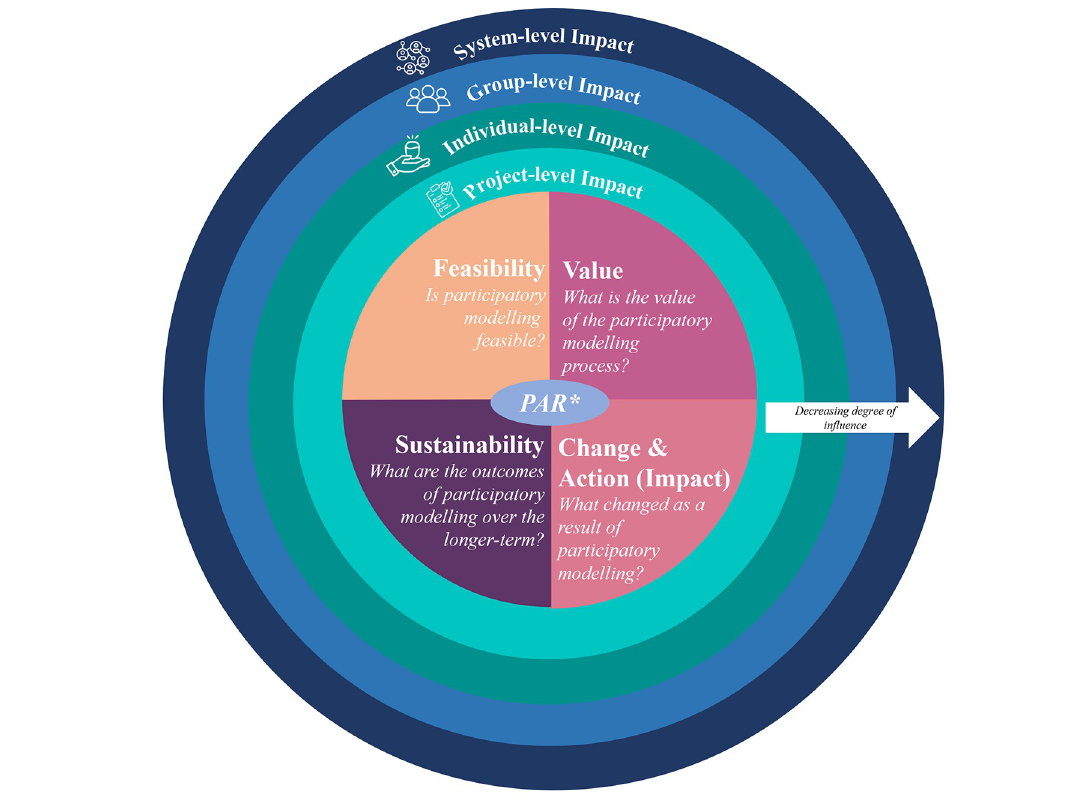
Fig 4. Evaluation framework underpinned by participatory action research, with consideration of impacts across the project-, individual-, group-, and system-level.